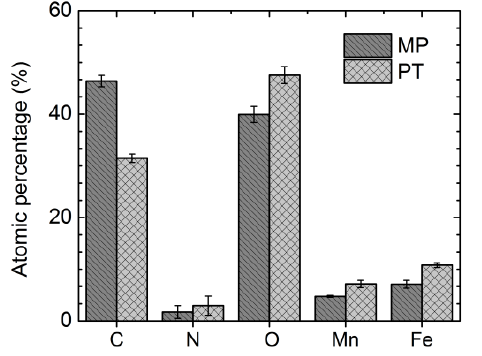
Figure 2. Surface element concentration for the MP and PT Figure 2 . Surface element concentration for the MP and PT conditions.